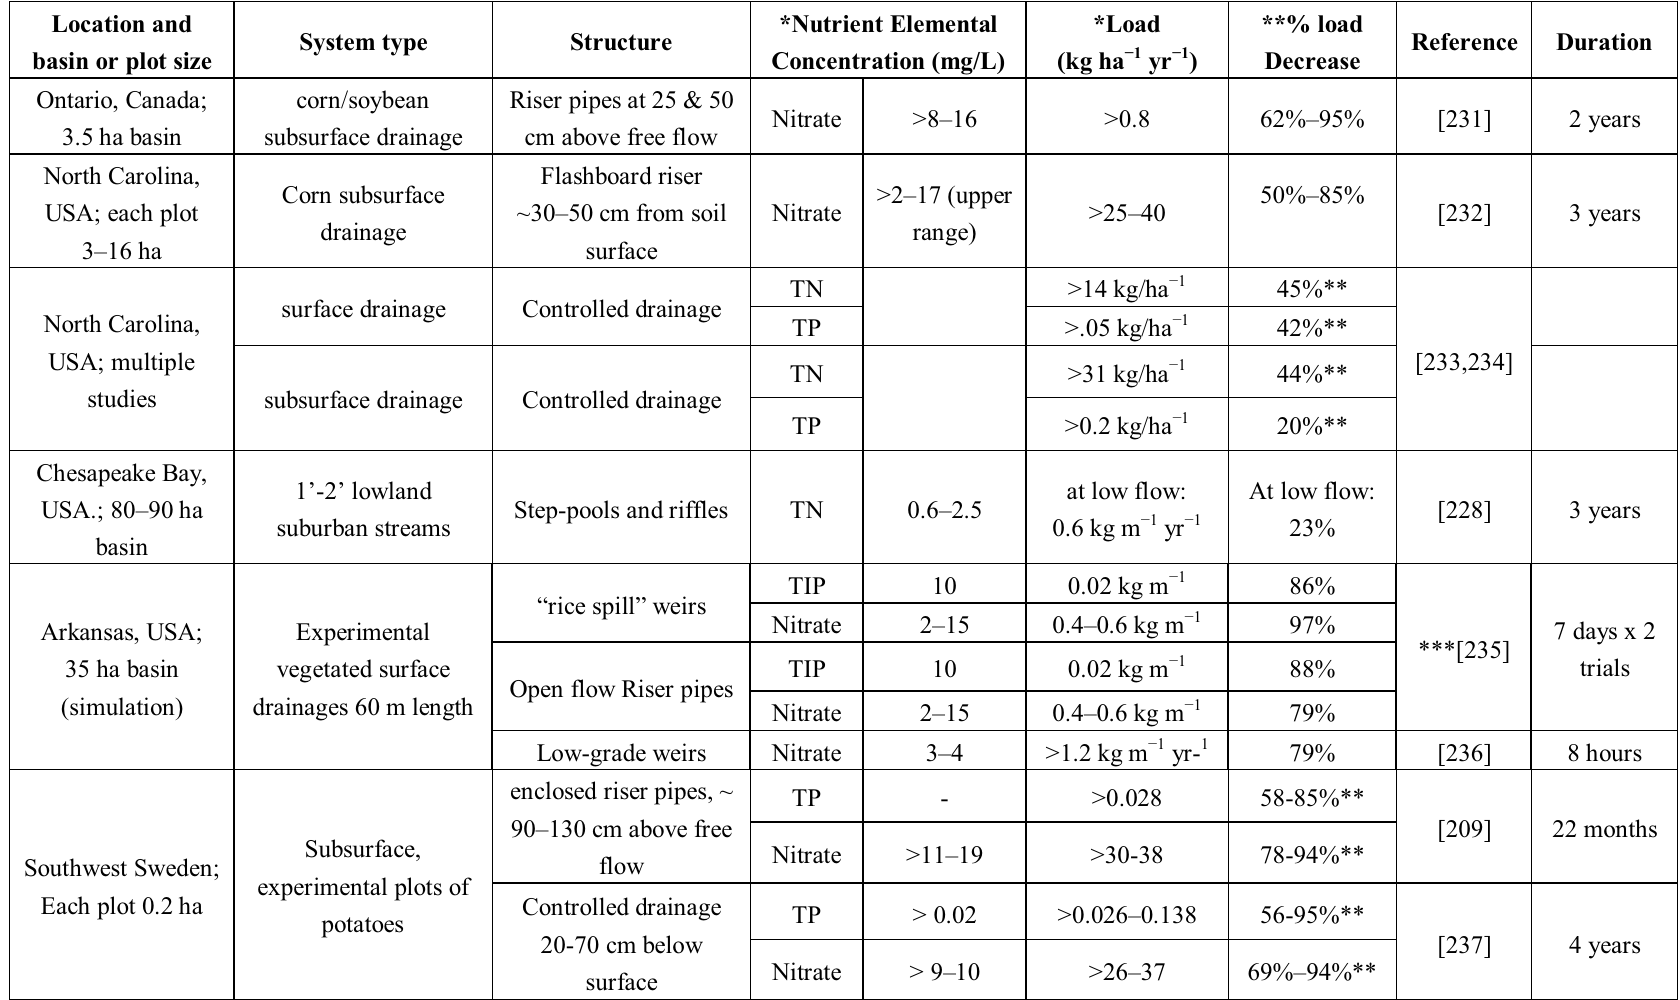
Table 2. Decreases in nutrient loads using drainage management